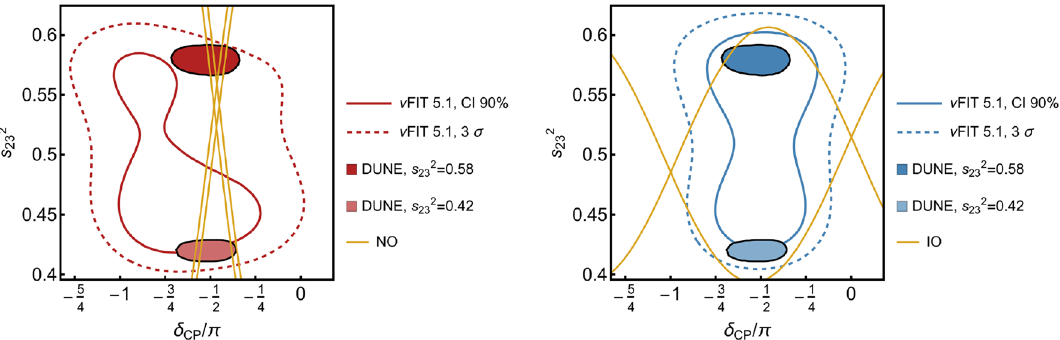
Fig. 4 The areas inside the lines represent the regions in the s 2 plane preferred by the global fit NuFit 5.1 to light neutrino oscillation data for normal ordering (red, left panel) and inverted ordering (blue, right panel). The dotted line corresponds to 3 σ CL, the full one to 90%